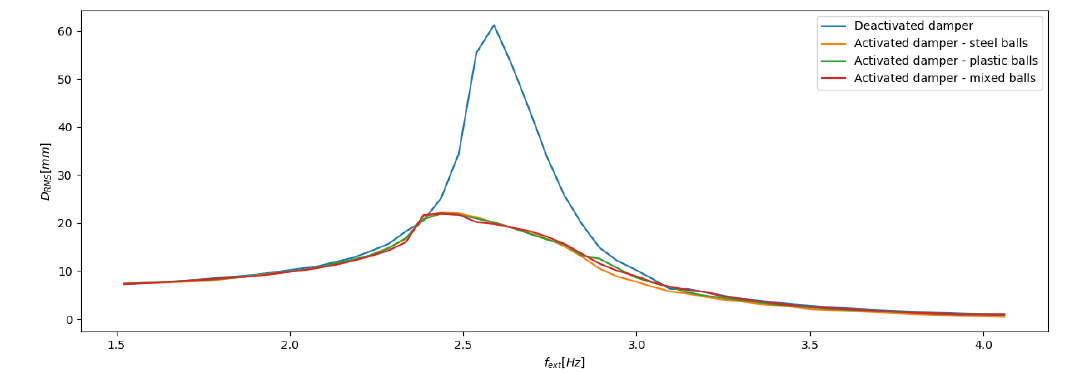
Figure 7. RMS of displacements for various grains